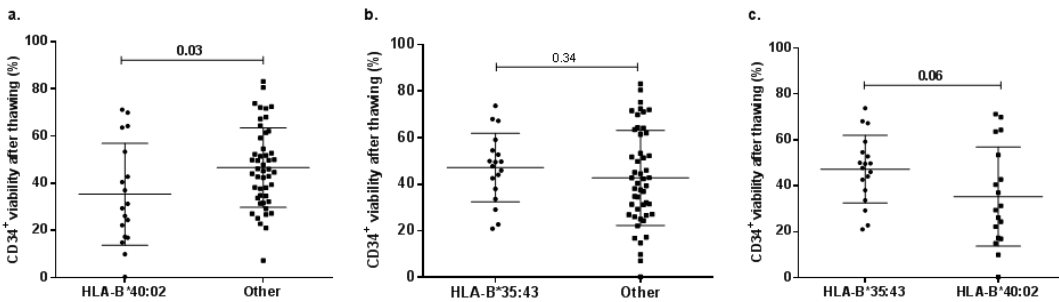
Figure 4. CD34 + cell viability percentage after thawing in UCB units bearing particular HLA-B alleles that were part of the statistically significant genotypes in the multivariate linear model. ( a ) There were statistically significant di ff erences in CD34 + cell viability between UCB units with HLA-B*40:02 ( n = 18) and without the allele ( n = 49). ( b ) There were no significant di ff erences in CD34 + cell viability between UCB donors with HLA-B*35:43 ( n = 18) and donors without it ( n = 49). ( c ) There were no significant di ff erences in CD34 + cell viability between UCB units with HLA-B*40:02 and with HLA-B*35:43. None of the UCB donors bared both alleles in a genotype.